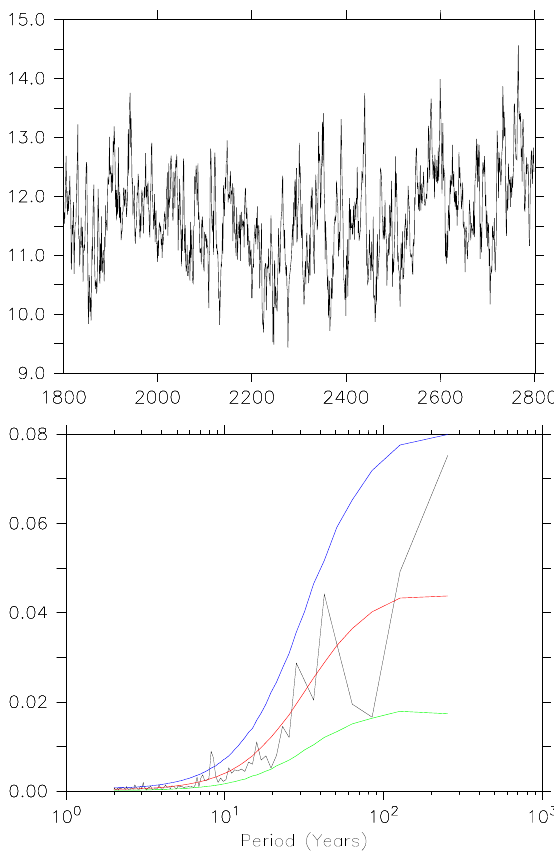
Fig. 15. The annual mean of the monthly maximum strength of the AMOC in the North Atlantic in Sv in the control run (top) and the power spectrum of this time series in Sv 2 (bottom). The sim- ulated AR(1) spectrum (red), and the minimum (green) and max- imum (blue) of the 95% confidence interval are also shown in the bottom panel.